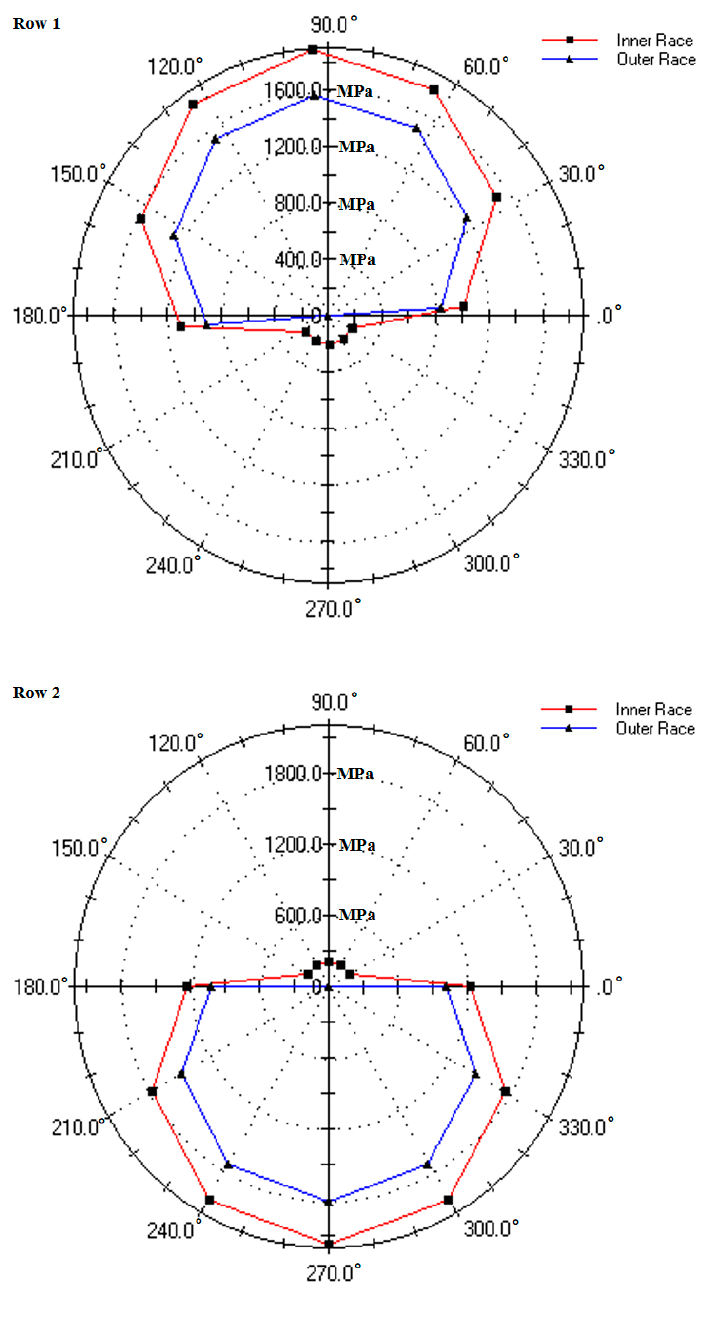
Figure 12. Bearing contact stress over preload of hub bearing. ( a ) Preload 0 μ m ( b ) Preload 25 μ m. All requirements for the fatigue life and static safety factor of the bearing, loads on the inner / outer raceways, contact stress, and truncation according to ISO 76 and 281 were satisfied